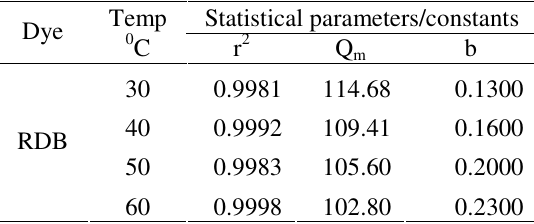
Table 4. Dimensionless separation factor (R